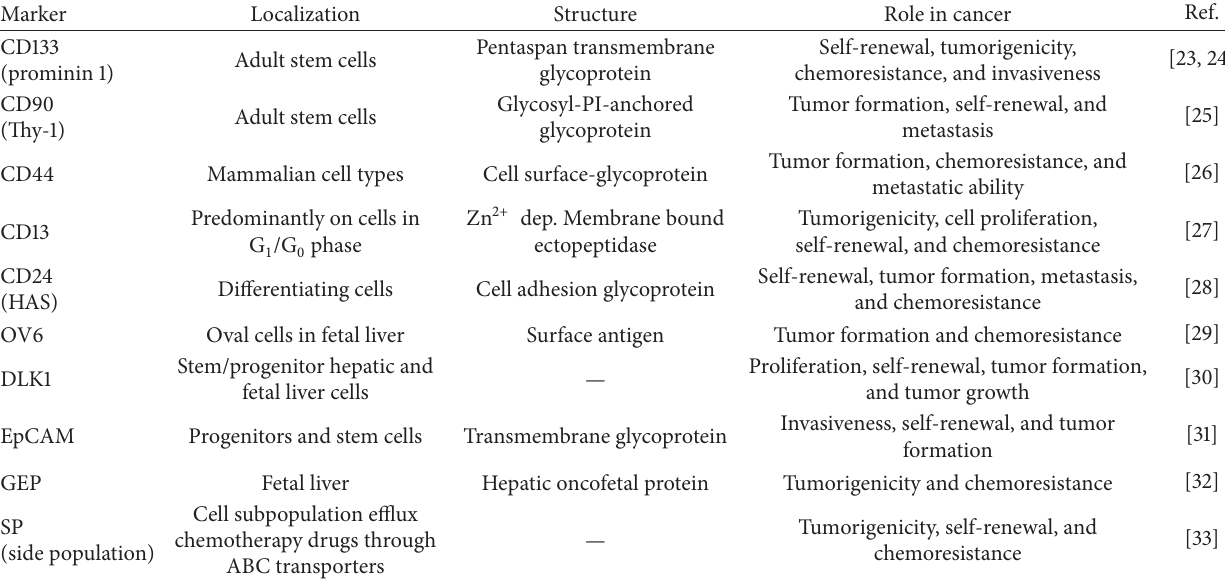
Table 1: Cell surface marker of hepatic cancer stem